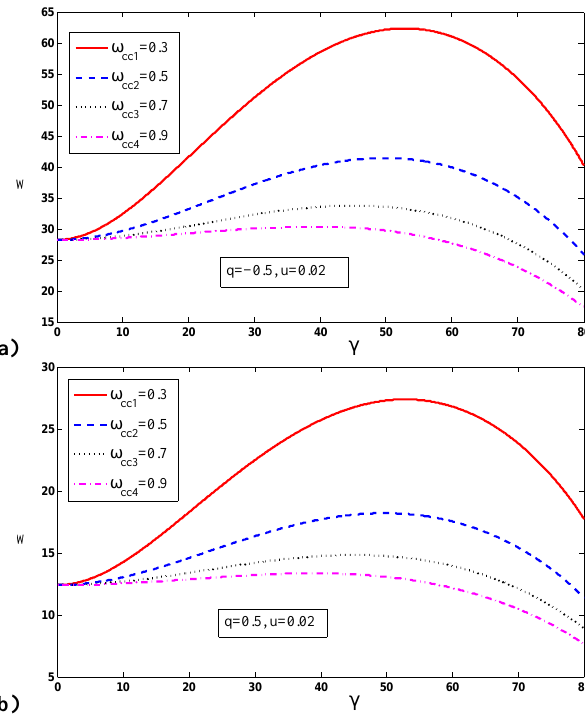
Fig. 2. Soliton amplitude ϕ 0 with respect to γ with different values for the parameter q .